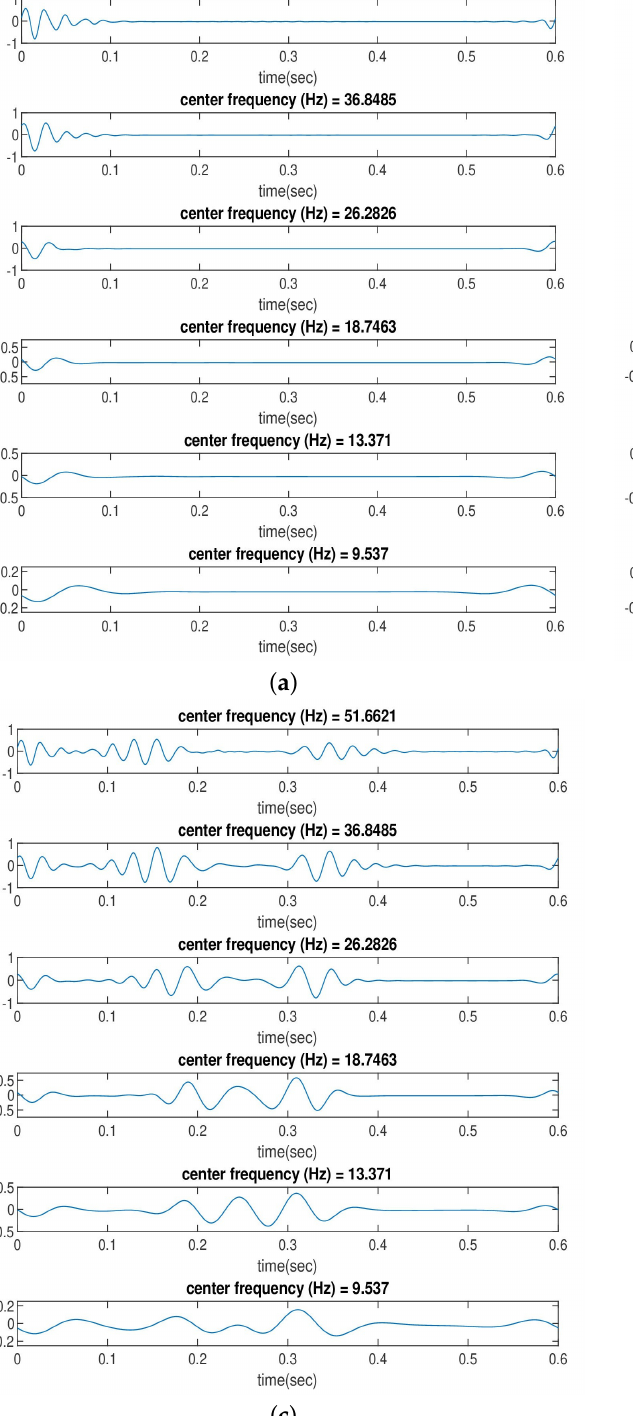
Figure 9. CWT coefficients at different scales generated using Morlet wavelet. ( a ) Healthy; ( b ) one broken bar; ( c ) two broken